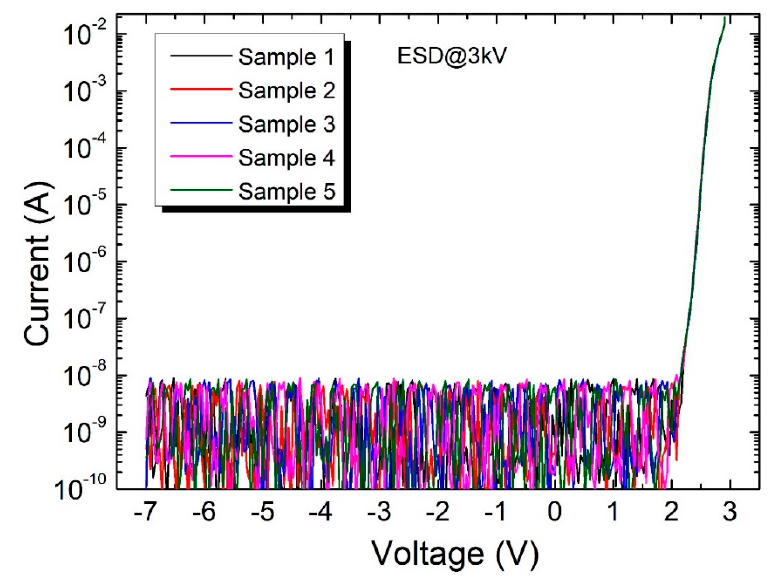
Figure 2. Current–voltage curves after an ESD bias of 3 kV. All samples were passed.